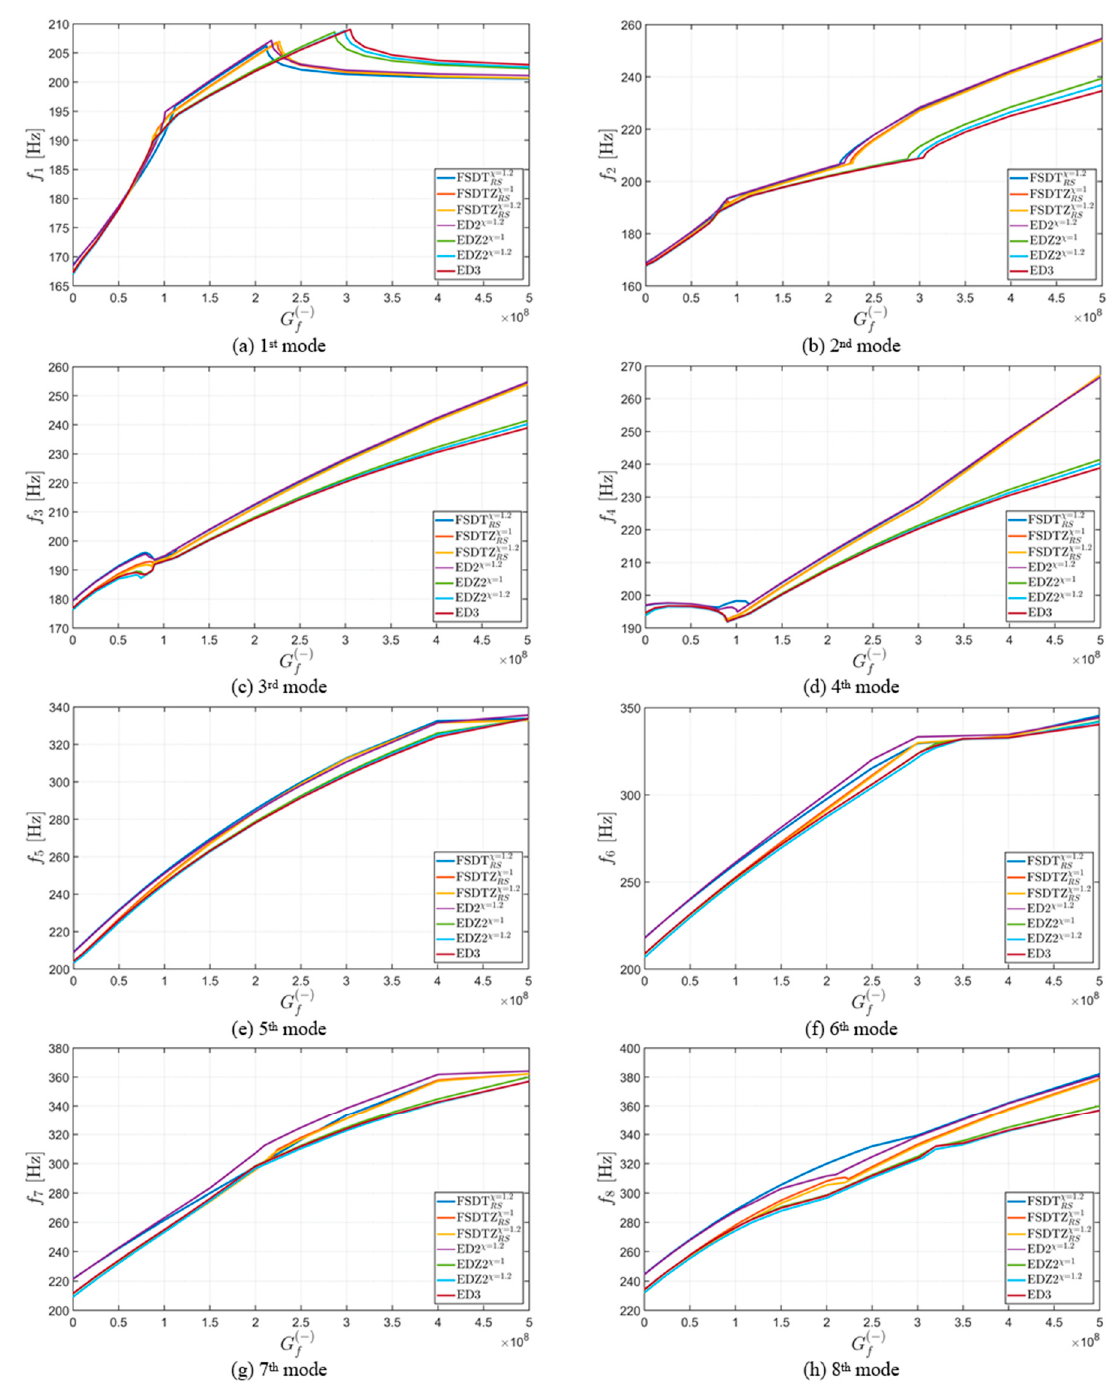
Figure 10. Frequency variations of a CFCF cylindrical surface (Figure 4b) reinforced by CNTs distributed as in Figure 5b. The mass fraction was w r = 0.25, and the agglomeration parameters µ 1 = 0.5 and µ 2 = 0.75. The Chebyshev-Gauss-Lobatto grid distribution was employed, with I N = I M = 25. The following mode shapes are considered: ( a ) 1st mode; ( b ) 2nd mode; ( c ) 3rd mode; ( d ) 4th mode; ( e ) 5th mode; ( f ) 6th mode; ( g ) 7th mode; ( h ) 8th mode.